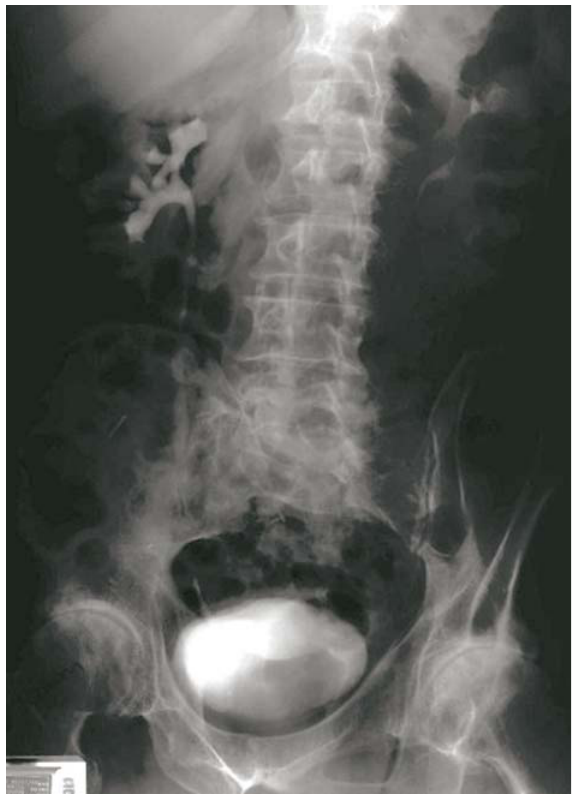
Figure 3 – Intravenous pyelogram at eight months postopera- tively showing a patent graft with no evidence of stricture or